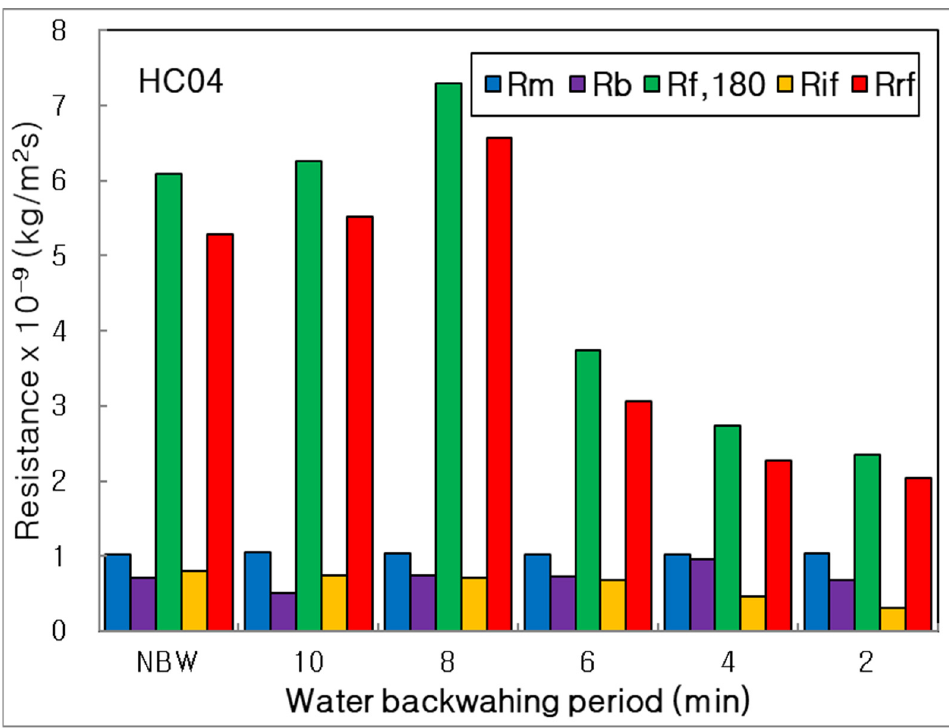
Figure 8. Influence of water backwashing period on resistances of membrane, boundary layer, final, irreversible and reversible membrane fouling (R m , R b , R f,180 , R if , R rf ) in the combined process of seven channel alumina MF (HC04) and PP beads with UV irradiation and periodic water backwashing.